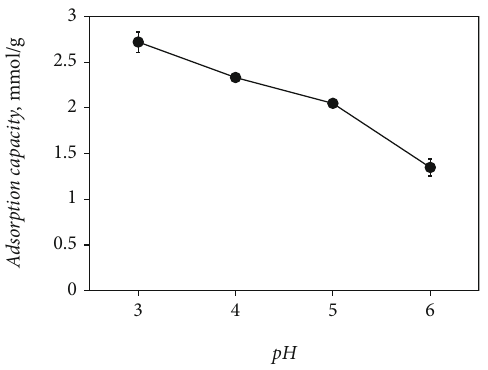
Figure 5: Separation of IA using CSK6 adsorbent at 30 ° C and di ff erent pH conditions. Initial itaconic acid concentration of